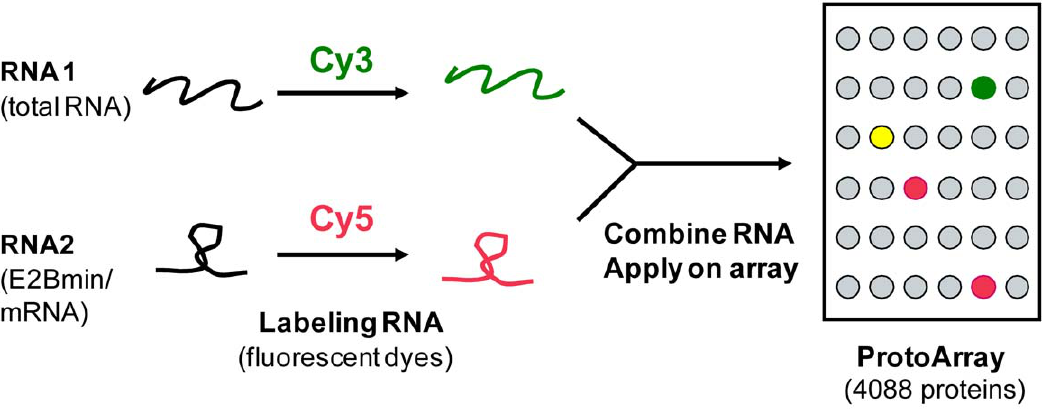
Figure 1. Identification of RNA-binding proteins with protein microarrays. Protein microarrays (Protoarrays) contained 4,088 different yeast proteins ( , 70% of the proteome) individually spotted in duplicates onto a modified glass slide. The arrays were probed with a mixture of fluorescently labeled RNAs. After washing, the arrays were scanned and analyzed for proteins that bound either labeled RNAs.